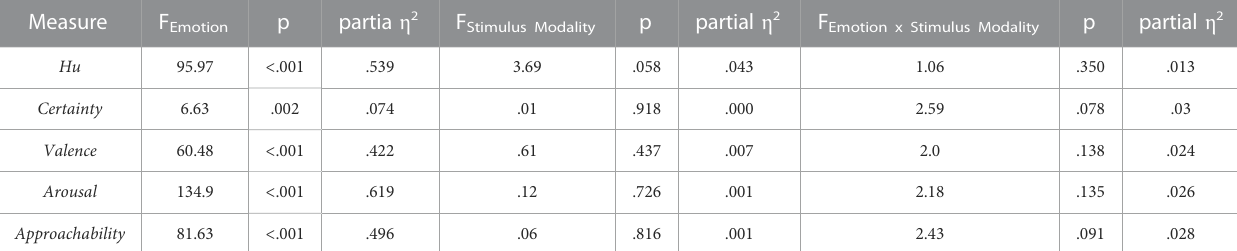
Certainty Valence 60.48